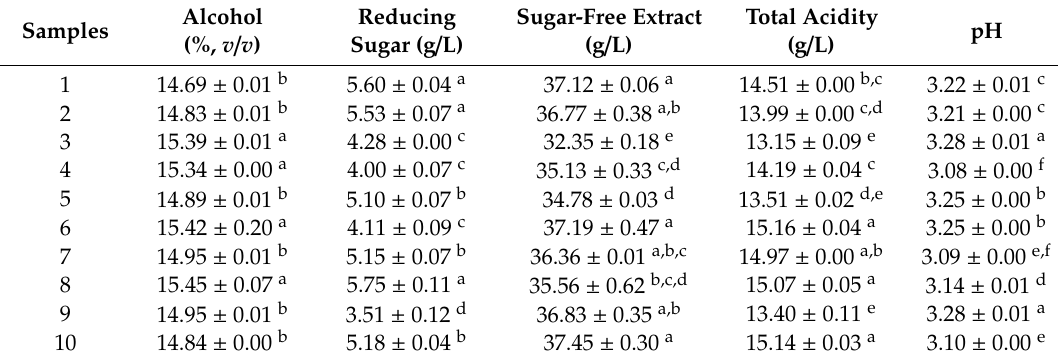
Table 1. Physicochemical indices of hawthorn